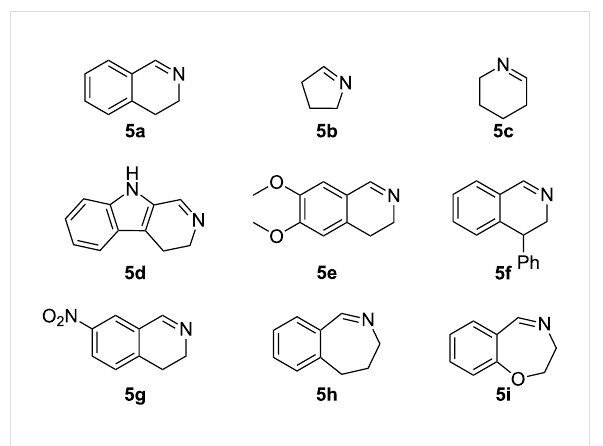
Figure 2: Cyclic imines employed in nitro-Mannich/lactamisation